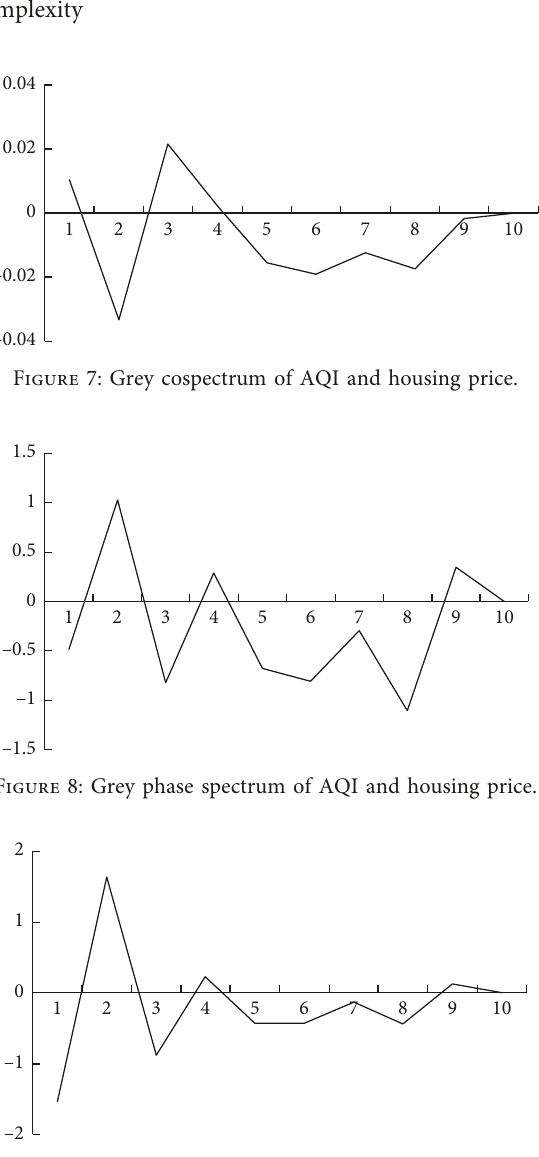
Figure 9: Grey lag time length of AQI and housing price.